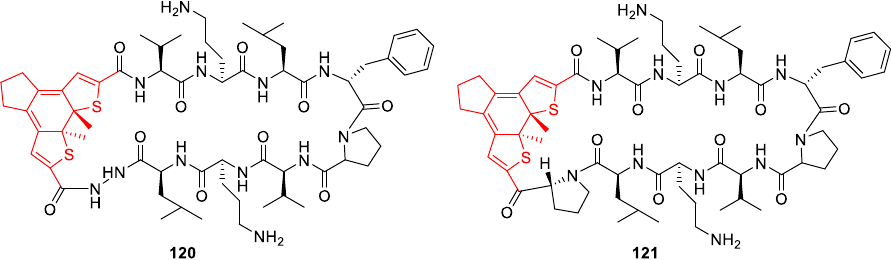
Figure 21. Photoswitchable gramicidin S analogs, the photoswitch unit indicated in